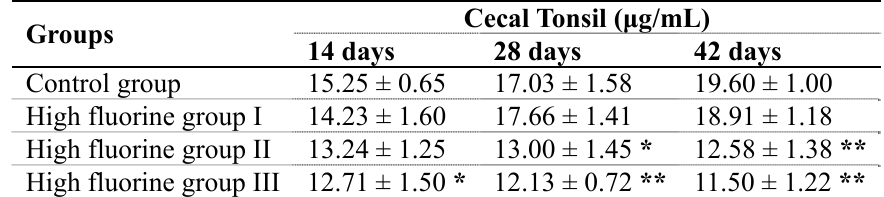
Table 2. Change of the IgA content in